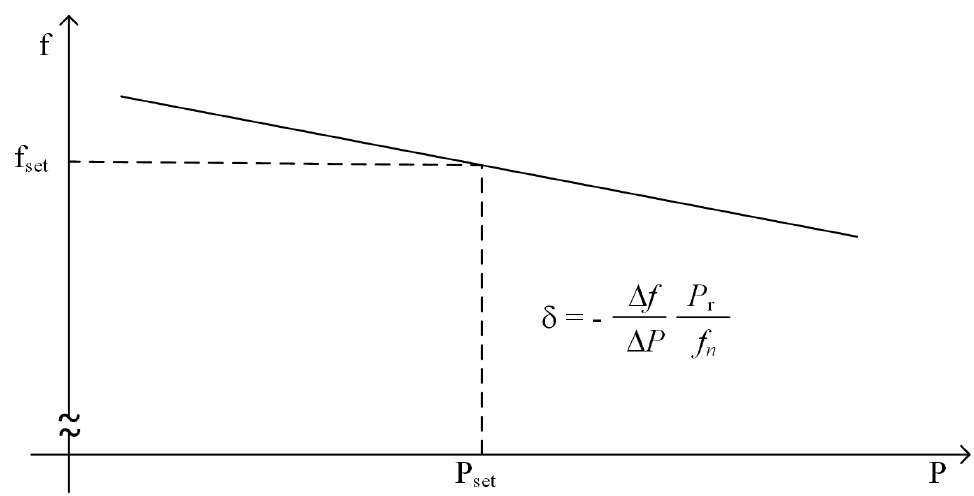
Figure 7. System model.